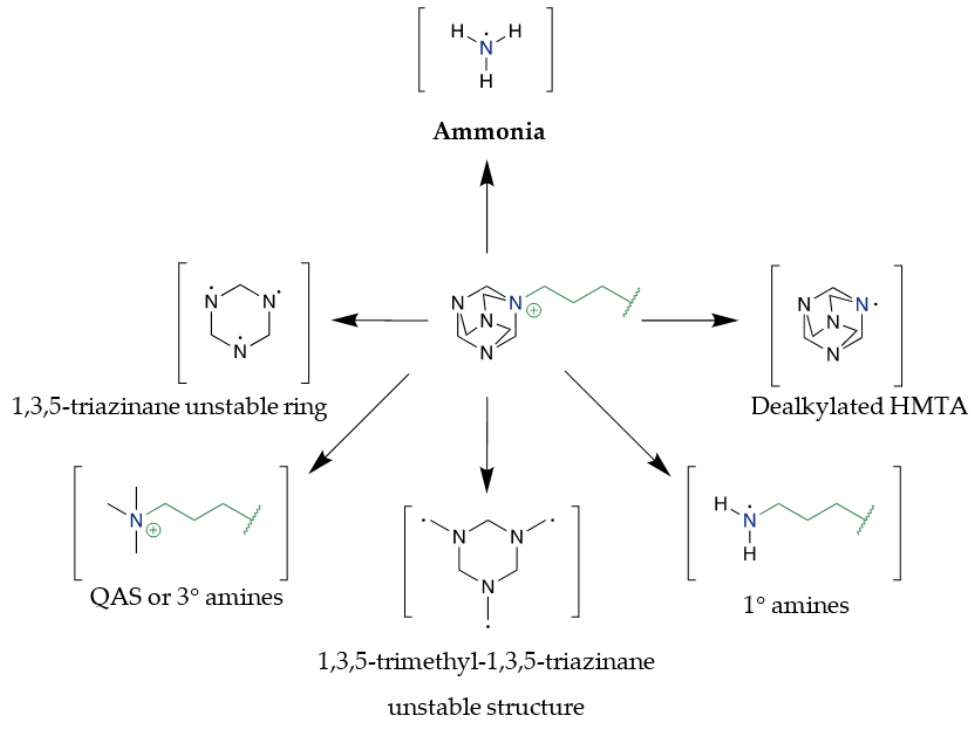
Figure 4. Proposed pathways of thermal decomposition of HMTA-based ILs.